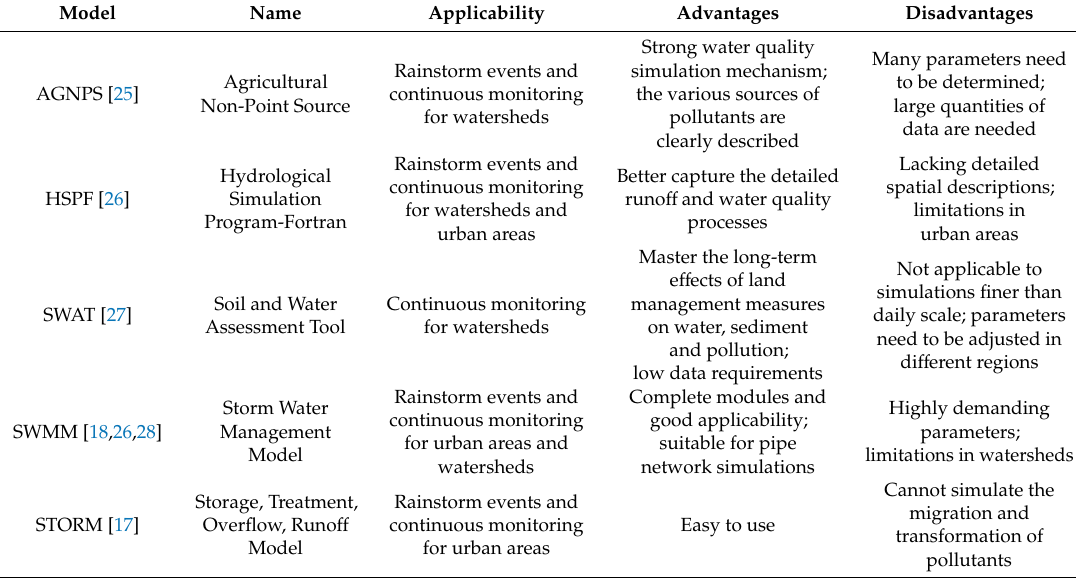
Table 1. Some commonly used physical-based non-point source (NPS)